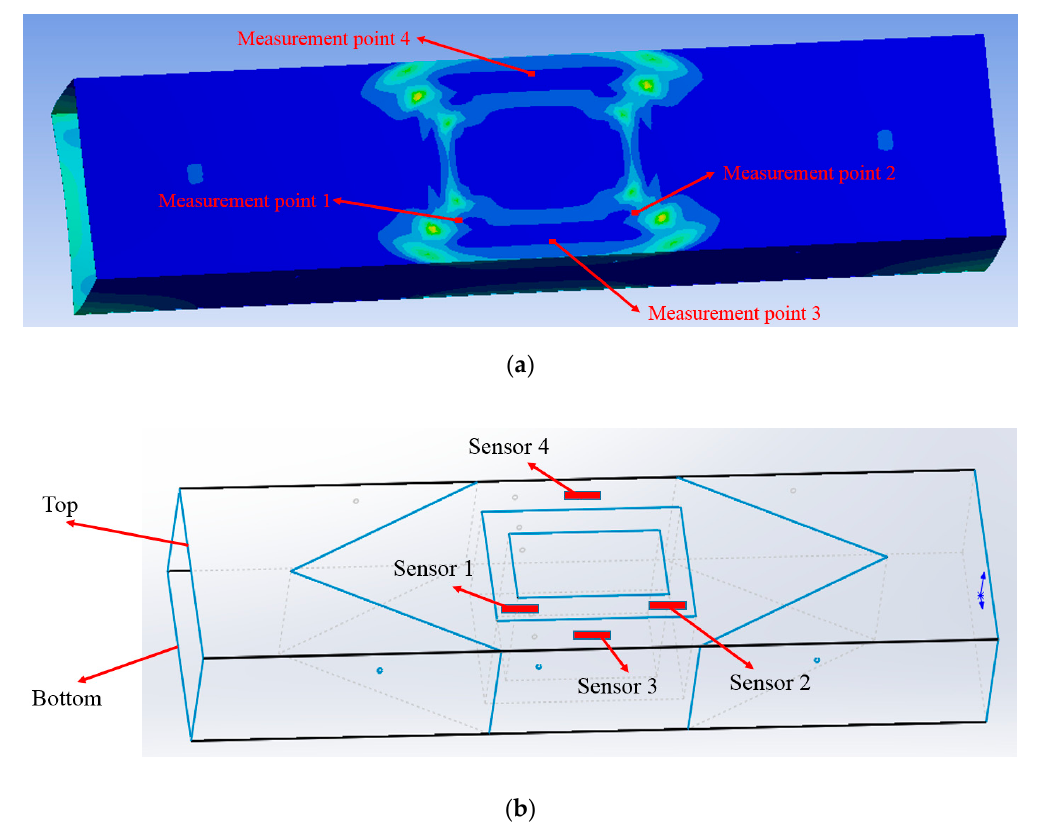
Figure 17. ( a ) Strain distribution under a certain working condition; ( b ) Arrangement of FBG sensors.